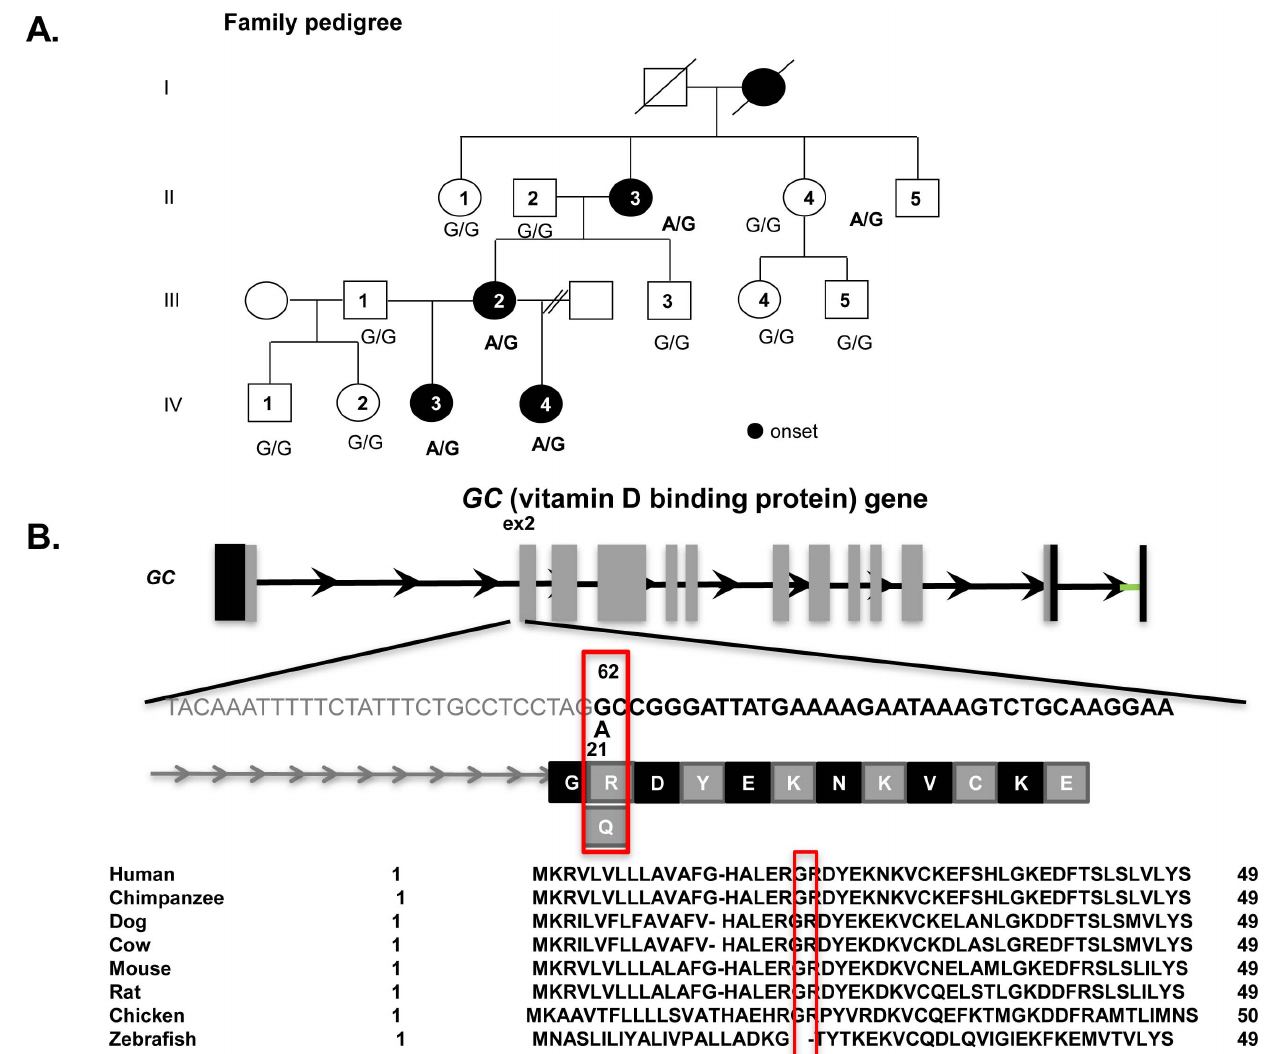
Figure 1. Family pedigree and sequence of GC (vitamin D binding protein). A ) Squares: males; circles: females; solid symbols: patients with severe myalgia and migraine. B ) The mutation results in a substitution at the 62 nd amino acid (G to A).